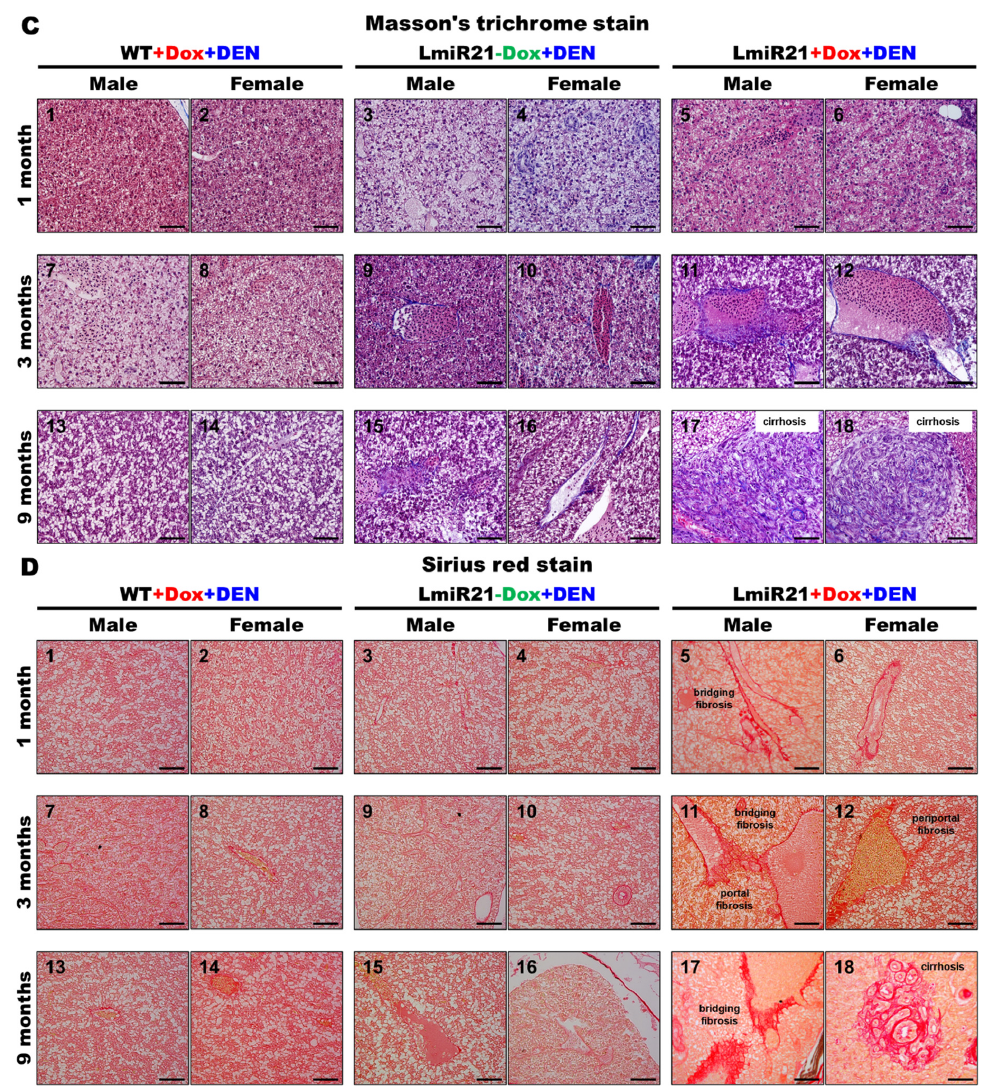
Figure 6. Increased susceptibility of LmiR21 zebrafish to diethylnitrosamine (DEN)-induced liver fibrosis and carcinogenesis. ( A ) Experimental design of three independent DEN treatments and doxycycline (Dox) dosing. ( B ) Representative images of livers with microscopic tumors identified following hematoxylin & eosin staining (indicated with arrows) one, three, and nine months after DEN treatment. Scale bar: 100 μ m. ( C ) Representative images of livers with microscopic injuries identified by Masson’s trichome staining at one, three, and nine months after DEN treatment. Scale bar: 50 μ m. ( D ) Representative images of livers with microscopic injuries identified by Sirius red staining at one, three, and nine months after DEN treatment. Scale bar: 50 μ m. clusions are unaffected. The original article has been updated.